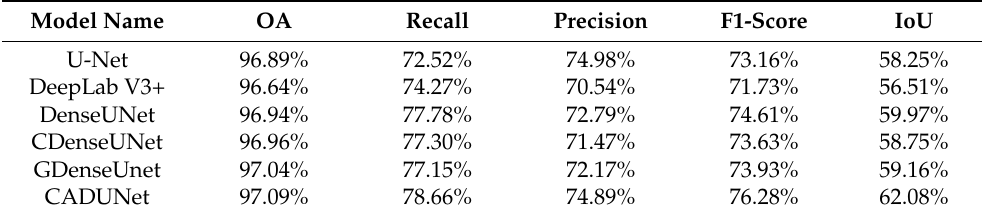
Table 2. Accuracy assessment of the road extracting results obtained by six methods in the CVPR